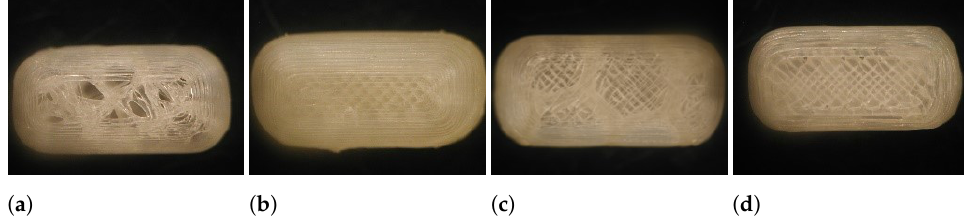
Figure 2. Different print settings resulted in visually different caplets. Caplets of run 1 ( a ), run 4 ( b ), run 5 ( c ) and run 9 ( d ) are